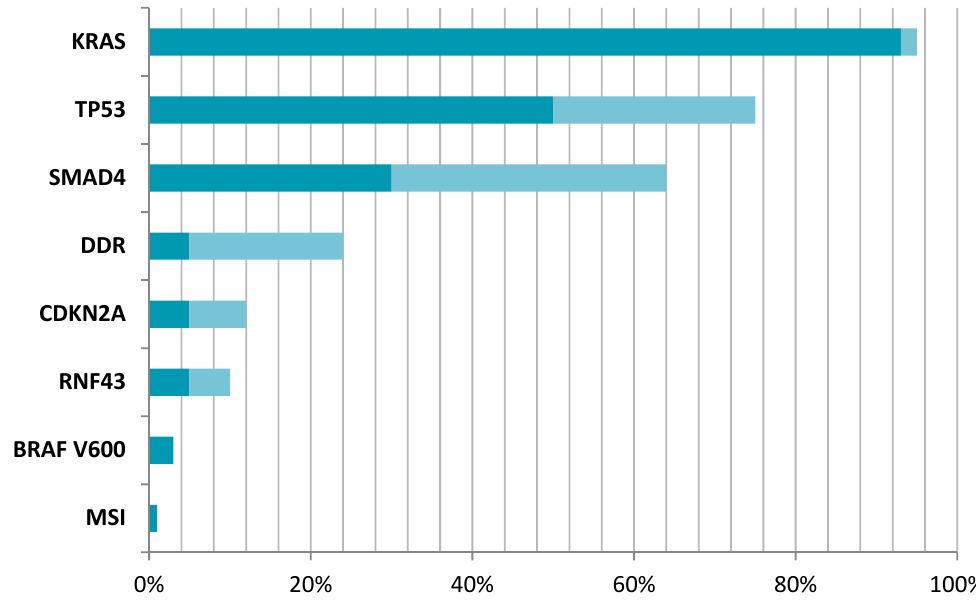
Figure 1. Prevalence of potentially targetable mutations in PDAC. KRAS—KRAS proto-oncogene, GTPase [33,35]; TP53— tumour protein p53 [59]; SMAD4—SMAD Family Member 4 [19,67]; DDR—DNA damage repair pathway mutations [18,19]; CDKN2A— cyclin-dependent kinase inhibitor 2A [12,75]; RNF43— ring finger protein 43 [19,24]; BRAF B-Raf proto-oncogene, serine/threonine kinase [82]; MSI—microsatellite instability [84]. Dark colour signifies minimal range of mutation reported, while lighter shade signifies maximum range of mutation reported within different references.